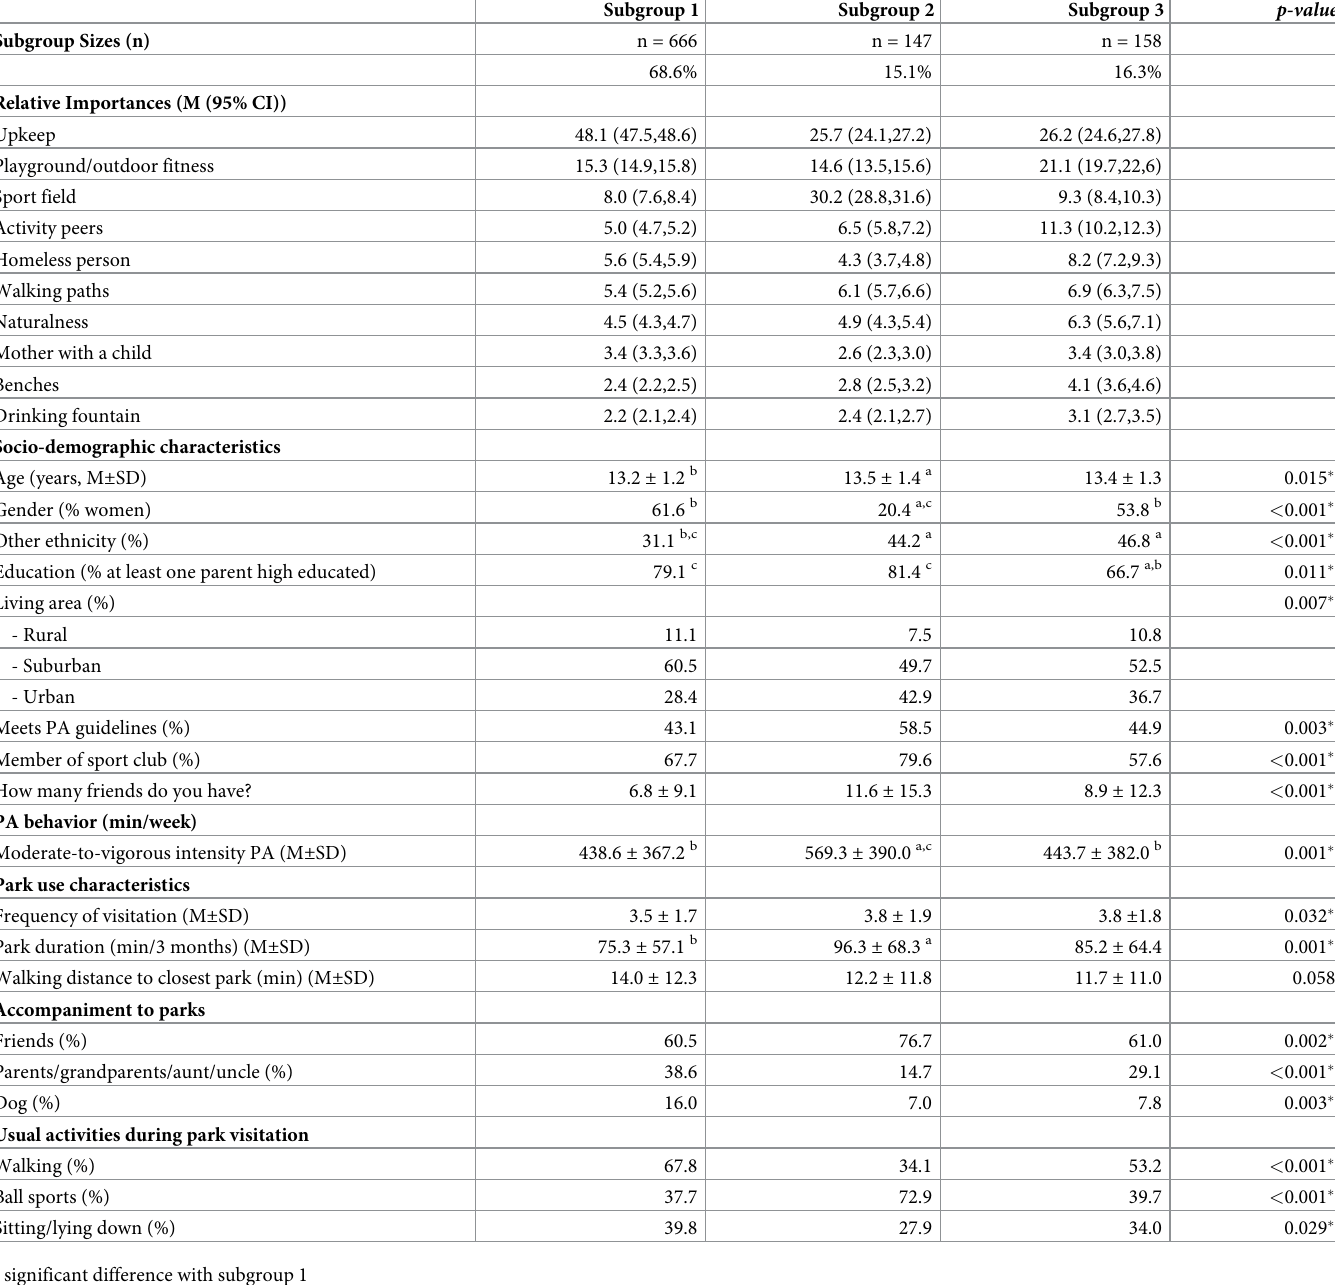
Table 1. Relative importances of each park characteristic for park visitation, socio-demographics, PA behavior and park use characteristics for the three subgroups identified by latent class